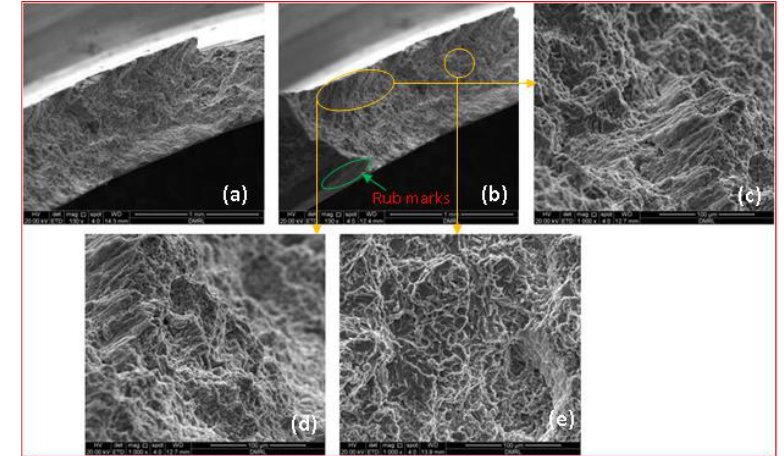
Figure 8: Fracture surface of dislodged metal piece of connector 1 in different views, as seen under SEM